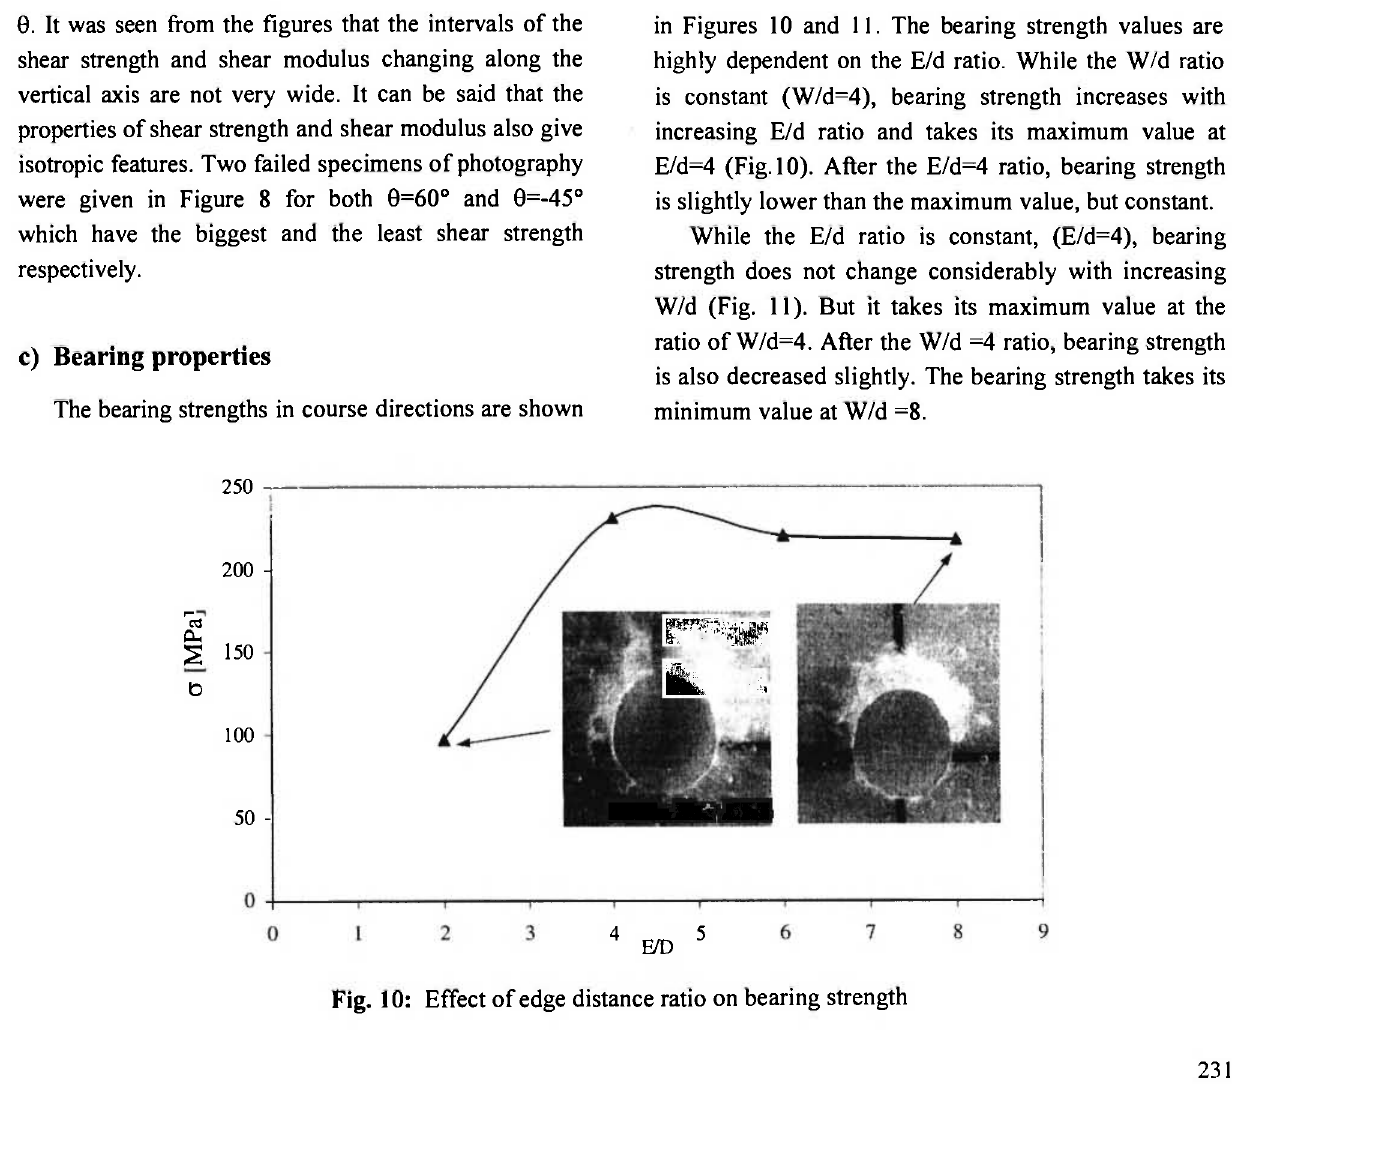
Fig. 9: Angular variation of shear modulus